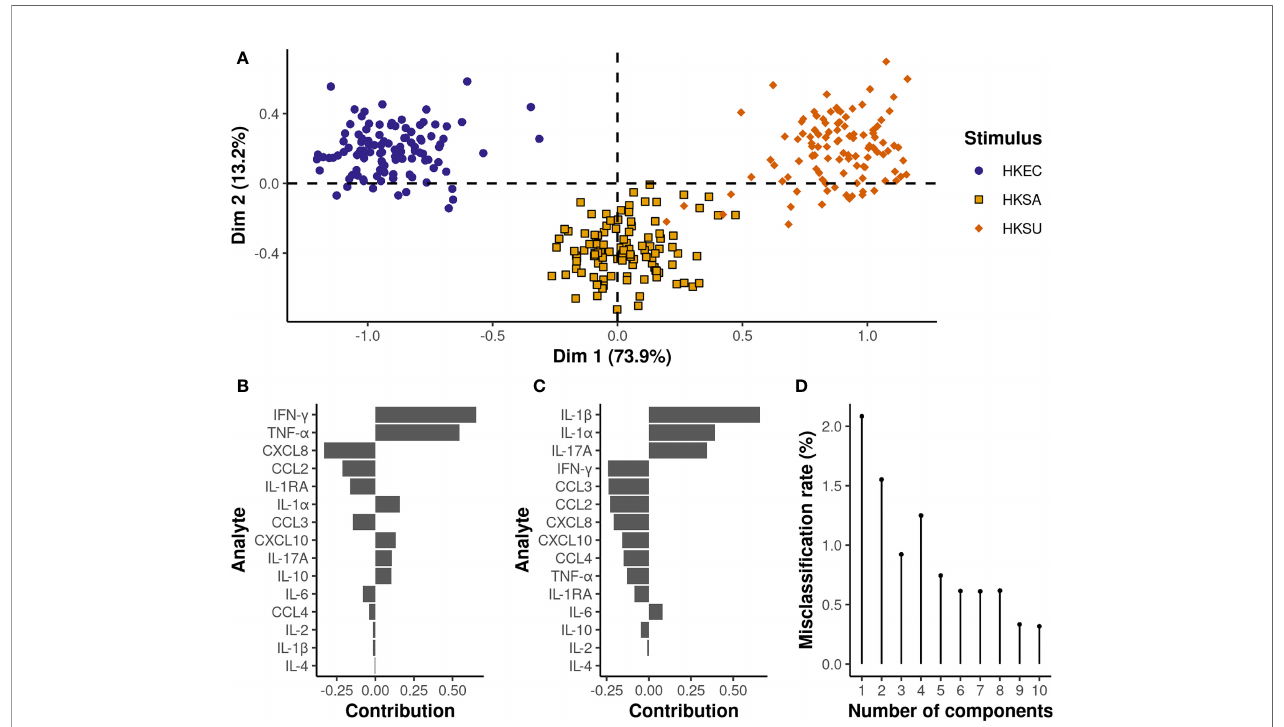
FIGURE 5 | Multilevel PLS-DA on bacterial stimuli adjusted MFI values reveals speci fi c expression patterns depending on the bacteria species. On the plot of the individuals (A) , each dot represents an individual cow, and the corresponding stimulus is de fi ned by its color. The x and y-axis correspond to the fi rst and second PLS-DA components, respectively. The proportion of variance explained by each principal component is written in brackets. The contribution of the cytokines to the fi rst (B) and second (C) principal components is represented by a horizontal barplot. The two fi rst principal components are suf fi cient to achieve an almost perfect misclassi fi cation rate (D)